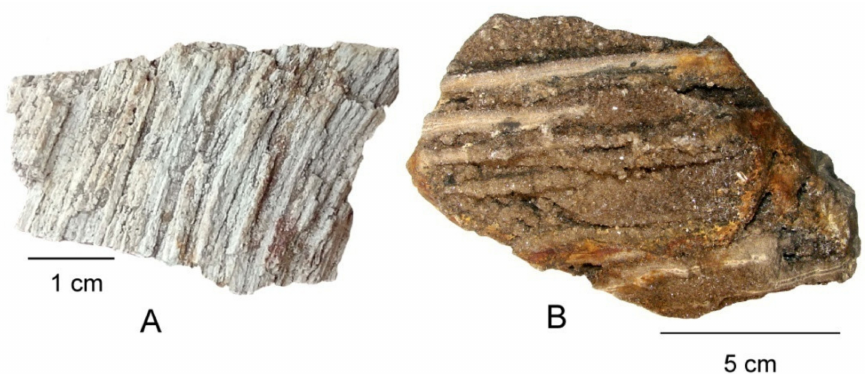
Figure 12. Quartz-mineralized angiosperm wood. ( A ) Koompassioxylon , Pleistocene, Ban Tak Fossil Forest, Thailand [50]. ( B ) Paraphyllathoxylon , Late Cretaceous, Brilliant, Alabama, USA. In both locations, euhedral quartz crystals have formed on the surface of silicified wood